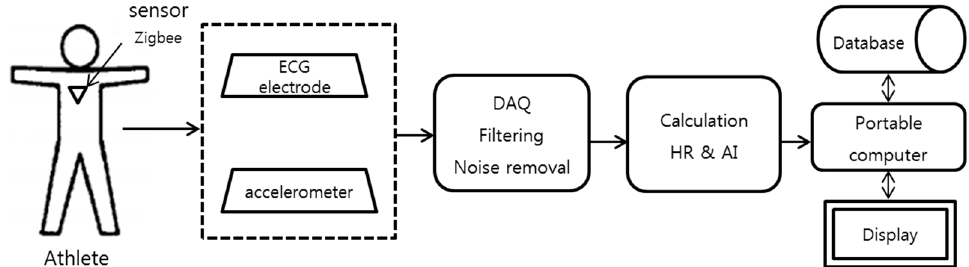
Figure 5. Schematic of the complete system (DAQ: Data Acquisition, AI: Agility Index).